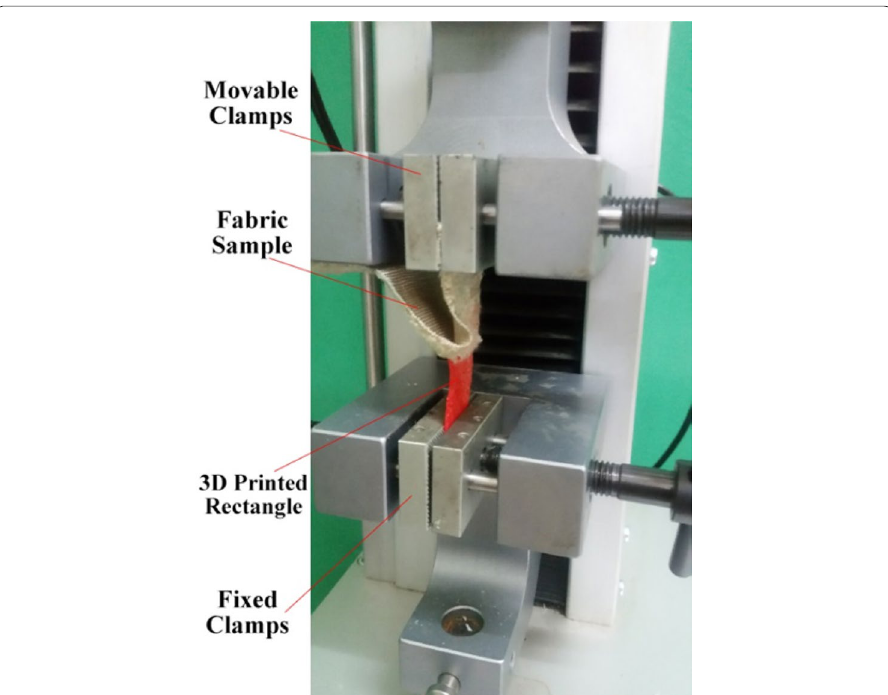
Fig. 3 Adhesion test on the Testometric Micro 500 model tensile tester